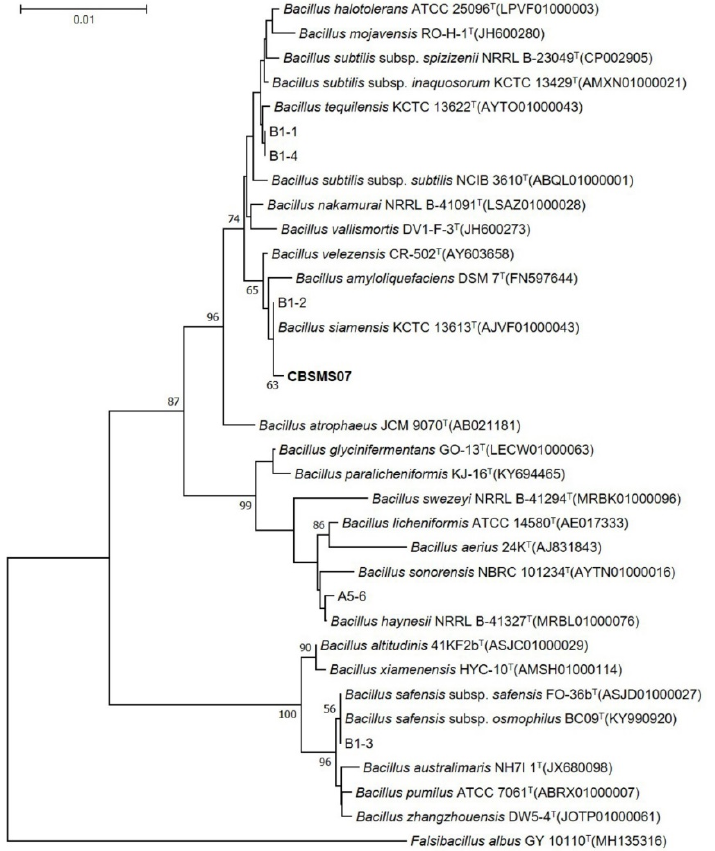
Figure 1. Phylogenetic tree created on almost full 16S rRNA gene sequences displaying interactions among CBSMS07 and a few closely associated taxa of the genus Bacillus. Here, the percentage amounts at the nodes are the quantities of the bootstrap assistance value based on 1000 resampled datasets retrieved from GenBank. The bar symbolizes 0.01 substitutions per nucleotide place.